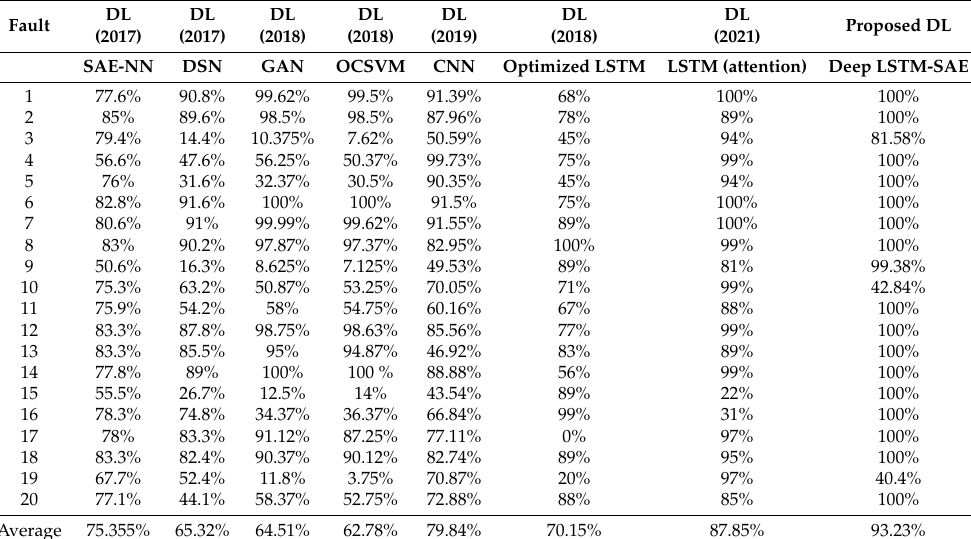
Table 4. Comparison of Fault Detection Rate with different methods (with all